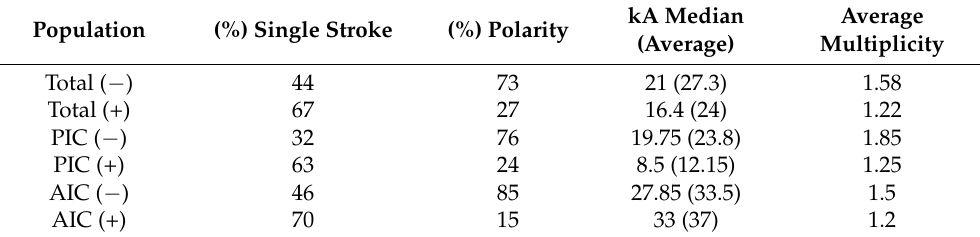
Table 2. Details of estimated lightning flash polarity and multiplicity in Tasmania detected by GPATS (January 2011–June 2019). Multiplicity is the average number of strokes per cloud-to-ground (CG) flash. The polarity and median peak current (kA) refer to the first stroke in each multiple stroke flash. Population (%) Single Stroke (%) Polarity